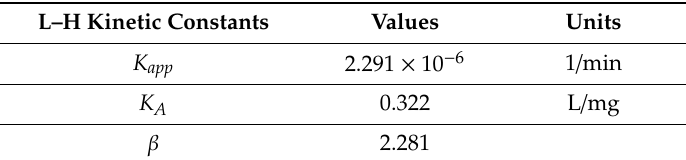
Table 2. Kinetic constant values.